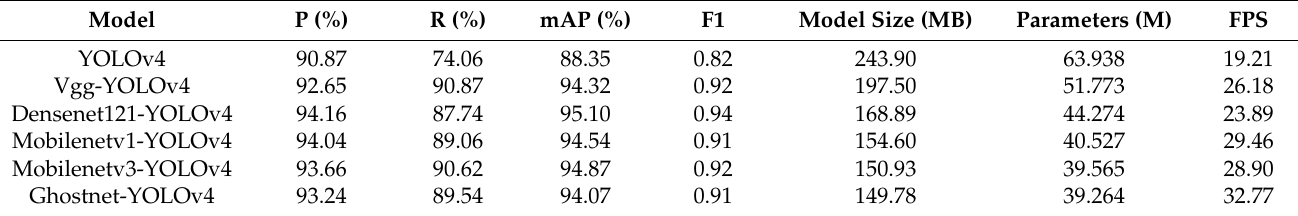
Table 2. Comparison of different backbone feature extraction